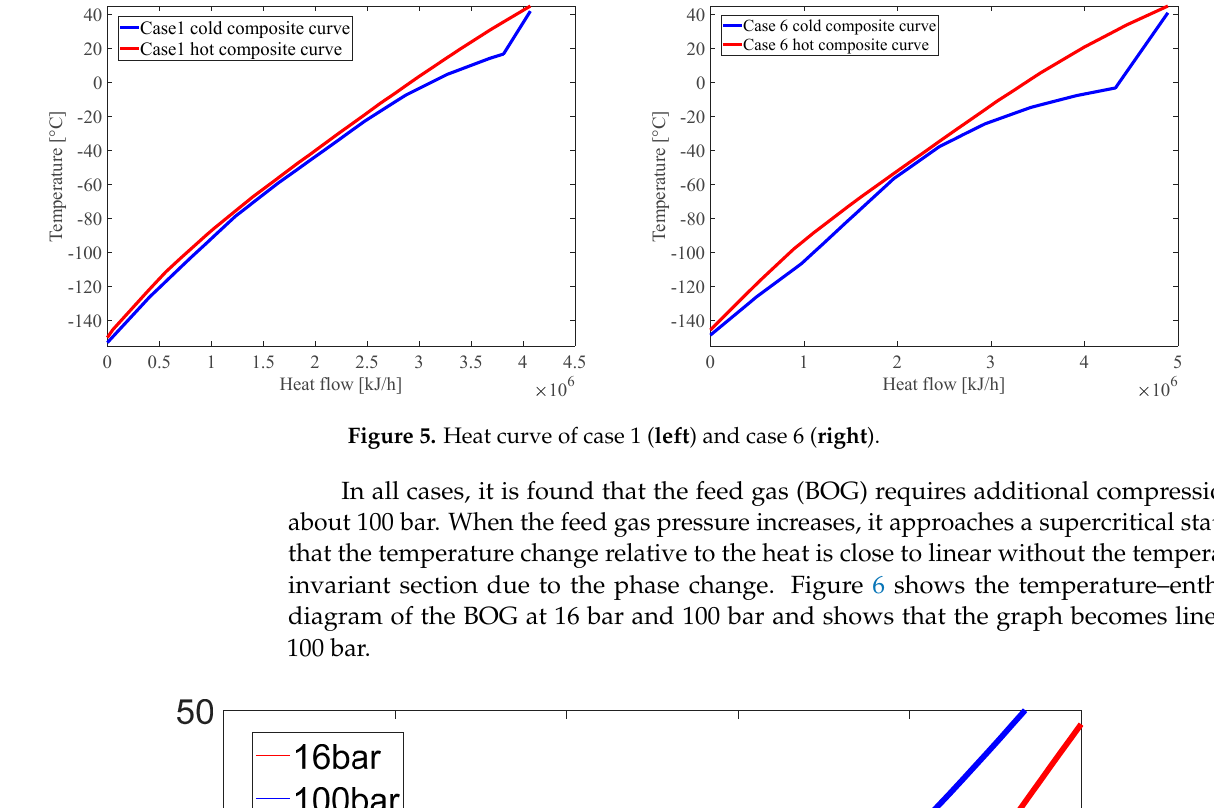
Figure 5. Heat curve of case 1 ( left ) and case 6 ( right ).